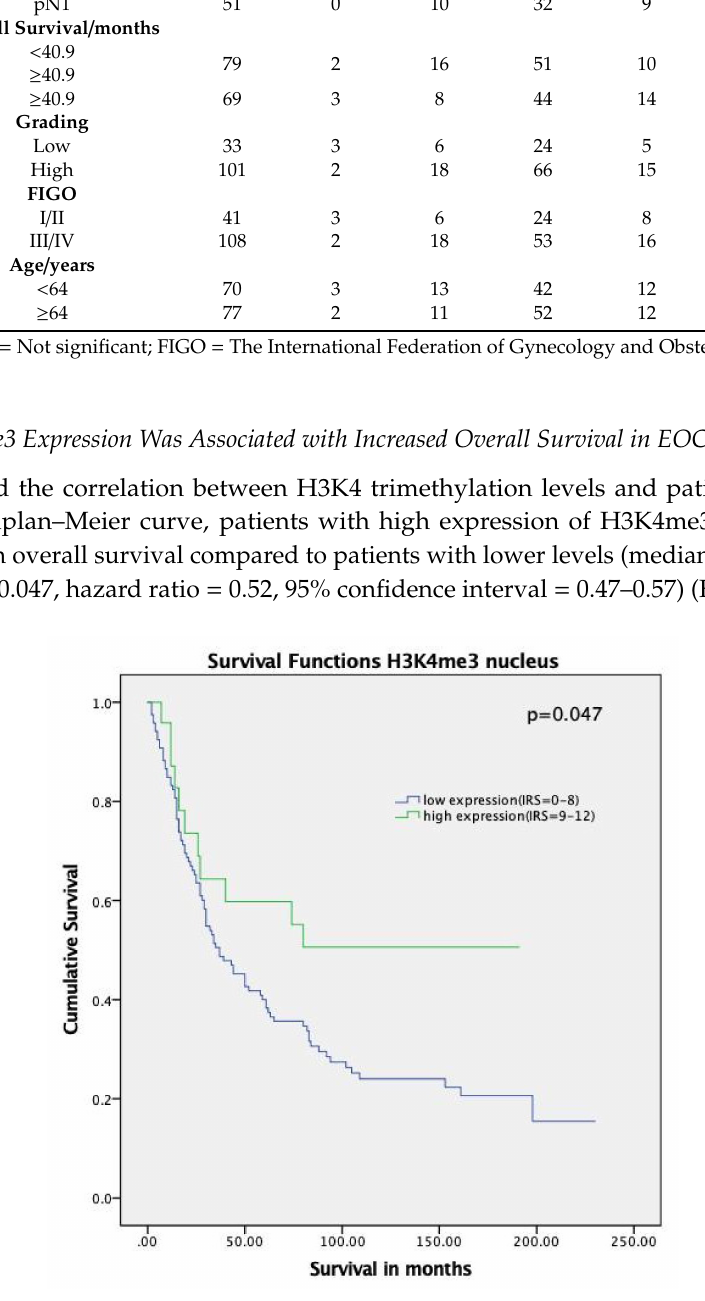
Figure 2. Kaplan–Meier analyses for overall survival: H3K4me3 ( p = 0.047) with strong expression (Immunoreactive Score (IRS) = 9–12, green) compared to negative, weak, and moderate expression (IRS = 0–8,